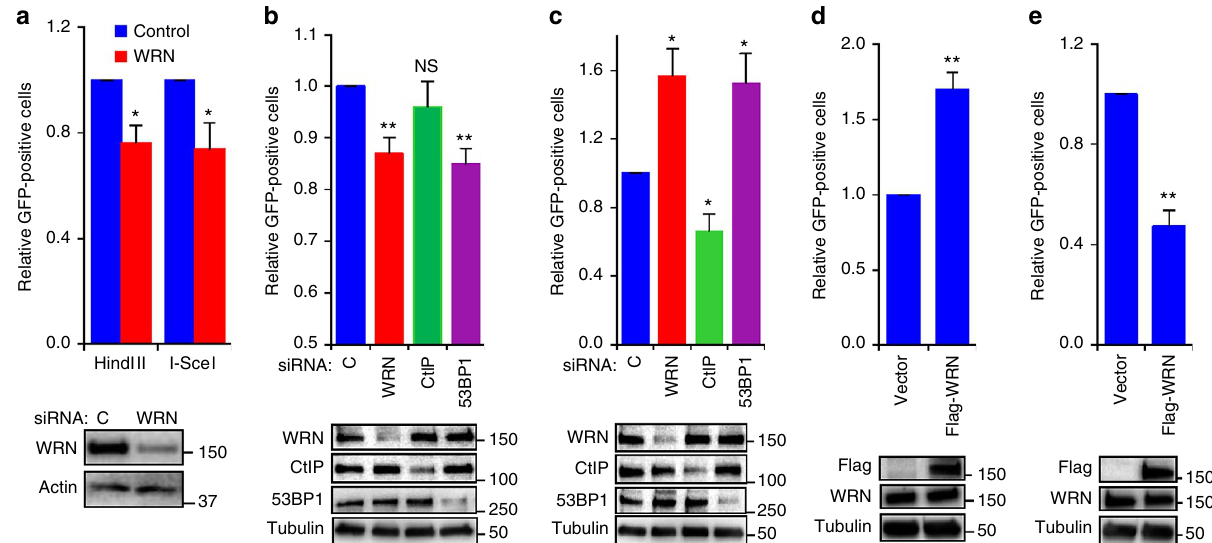
Figure 2 | WRN promotes c-NHEJ and inhibits alt-NHEJ. ( a ) pEGFP-Pem1-Ad2 reporter based NHEJ efficiency in siRNA transfected U2OS cells. Control and WRN knockdown cells were transfected with Hin dIII (cohesive ends) or I-Sce I enzyme digested (non-cohesive ends) pEGFP-Pem1-Ad2 along with DsRed and analysed for GFP and DsRed expressing cells by flow cytometry. ( b ) Total NHEJ efficiency in siRNA transfected EJ5 cells. ( c ) Alt-NHEJ efficiency in siRNA transfected EJ2 cells. ( d ) Expression of WRN promotes NHEJ. ( e ) WRN expression suppresses alt-NHEJ. DSBs in EJ2 and EJ5 cells were induced by transfecting I-Sce I expression plasmid. Graph represents relative repair efficiency as measured by GFP-positive cells normalized to DsRed expression. Immunoblots represent protein expression levels. Error bars represent SEM from three independent experiments. P value, *, o 0.05; **, o 0.01; NS, not